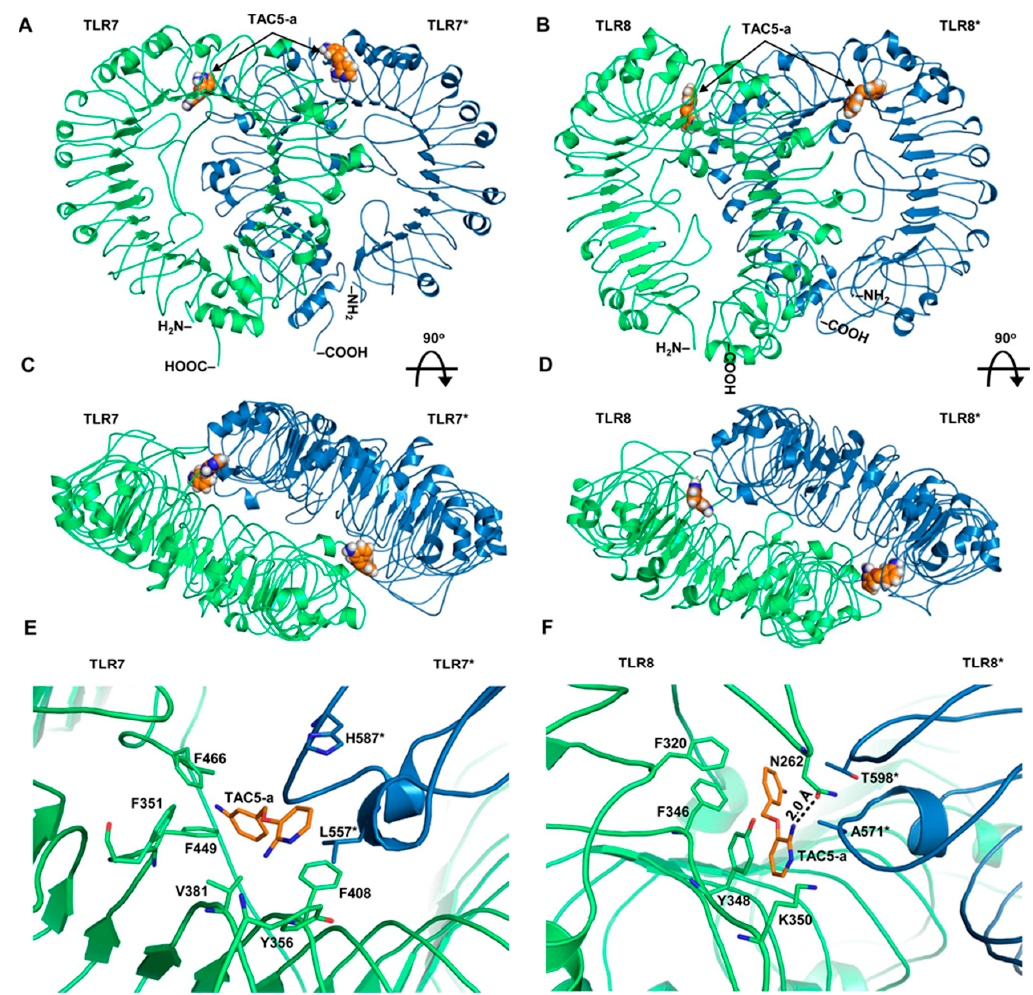
Figure 7. Structural models of TAC5-a bound to TLR7 and TLR8. ( A ) The overall structure of a homology model of human TLR7 having TAC5-a at the synthetic agonist binding cavity. ( B ) The structure of human TLR8 with TAC5-a bound to the agonist-binding site. ( C ) The top surface of TLR7 after 90° rotation of panel ( A ). ( D ) A 90°-rotated view of the panel ( B ). ( E ) Detailed intermolecular interaction of TAC5-a with the amino acids of TLR7. ‘*’ indicates chain B of the protein. ( F ) A close-up view of the intermolecular contacts between TAC5-a and TLR8 residues. ‘*’ indicates subunit B of the protein. The hydrogen bond (H-bond) is shown as a dashed line. The digit indicates the distance of the H-bond in Å. TAC5-a is shown as an orange stick. The chain As of both proteins are colored lime green and the chain Bs are sky blue.